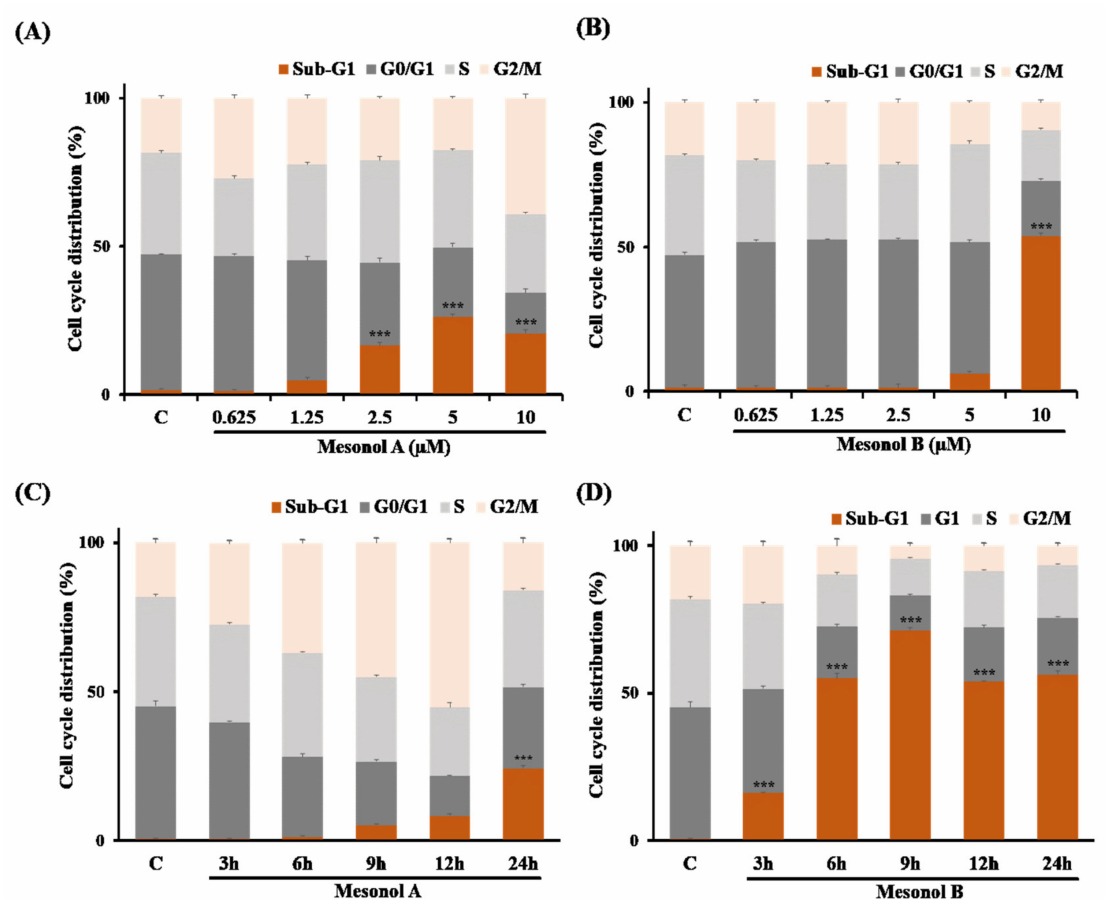
Figure 4. Effects of mesonols A ( 1 ) and B ( 2 ) on cell cycle progression and apoptosis in U937 cells. U937 cells were treated with various concentrations of ( A ) mesonol A or ( B ) mesonol B for 24 h and then harvested for cell cycle and sub-G1 analysis by flow cytometry, as described in Materials and Methods. For time course analysis, U937 cells were treated with ( C ) 5 µ M mesonol A or ( D ) 10 µ M mesonol B for 3–24 h, and cells were then subjected to cell cycle analysis at the indicated times. Values with different letters indicate significant differences, as determined by Dunnett’s method. *** p < 0.001 relative to the control